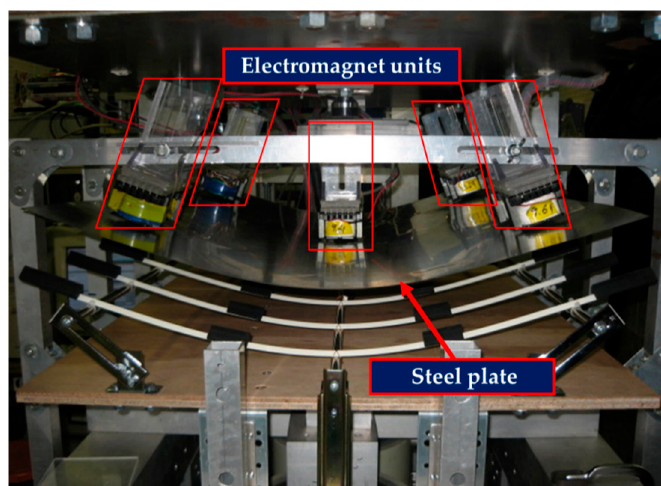
Figure 5. Photograph of the experimental apparatus. Table 1. The specification of five eddy-current gap sensors.